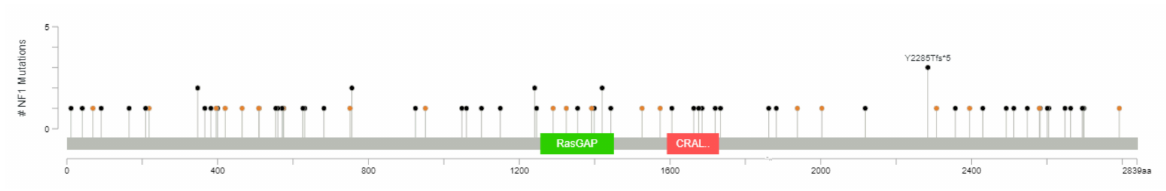
Figure 2. The spectrum of NF1 mutations in primary breast cancer (diagram from cBioPortal). Gene CNAs, available for a total of 3363 patients, are reported in Table 4. CNAs in one or more of the genes considered in this analysis are found in 283 (8%) of patients. KRAS and BRAF are amplified in 2.3% and 1.8% of patients, respectively. Deletions are rarer and